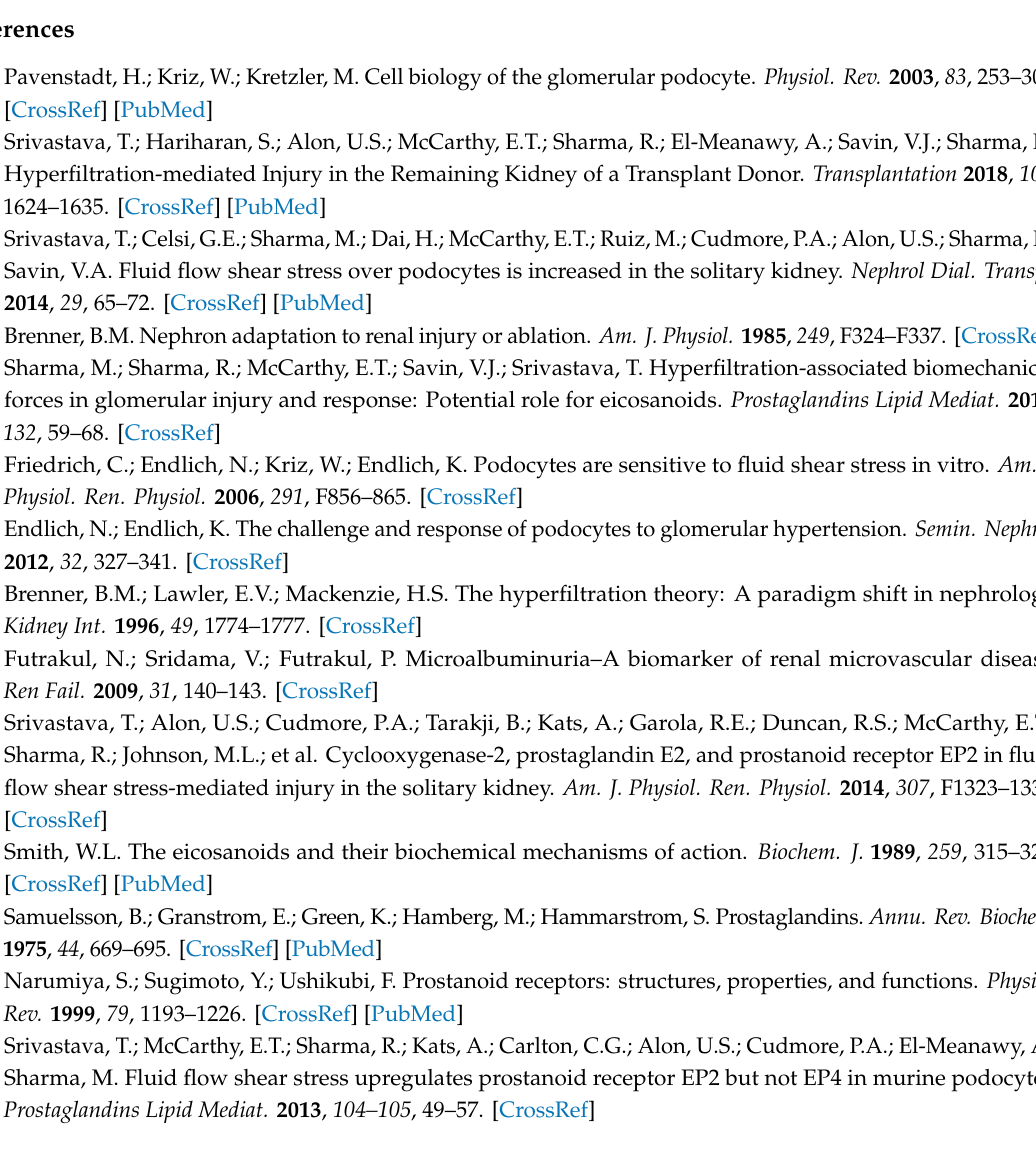
Figure S1: Di ff erentiation of hPC was confirmed by immunofluorescence of synaptopodin, podocin, and nephrin, Figure S2: Characterization of di ff erentiated and undi ff erentiated hPC. Figure S3: Expression of EP receptors in hPC, Figure S4: EP2 antagonist does not inhibit PGE 2 mediated COX2 upregulation when applied with the same concentration as PGE 2 . Table 1: Multiple Reaction Monitoring in negative mode for LC / ESI-MS /